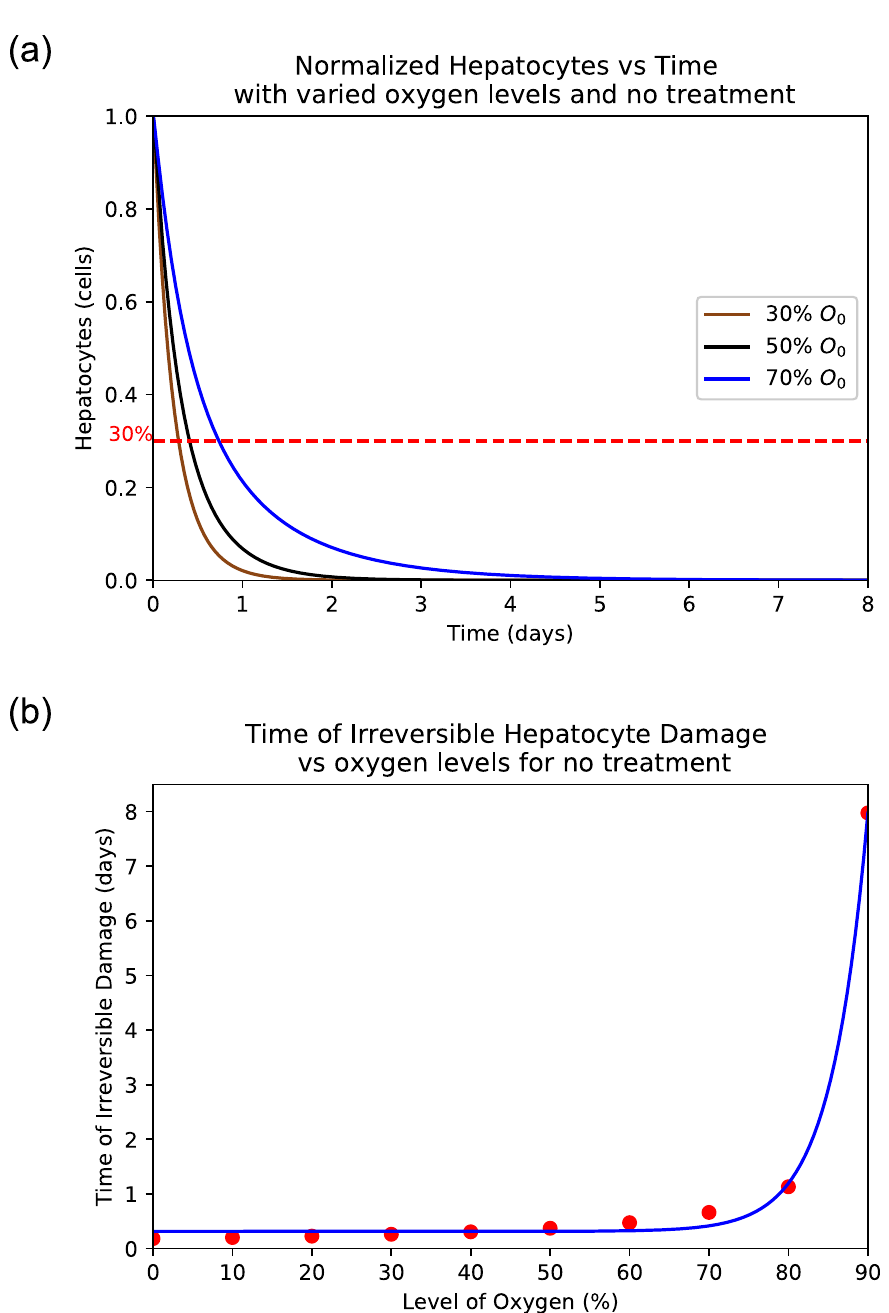
Fig 9. Demonstration of the Hepatocyte, AST, ALT, LDH level with varied O2 levels when there is no treatment. ( a ) Hepatocyte death with varied O2 levels when there is no treatment. ( b ) The estimated time of reaching the critical 30% Hepatocyte level for irreversible damage given the initial oxygen